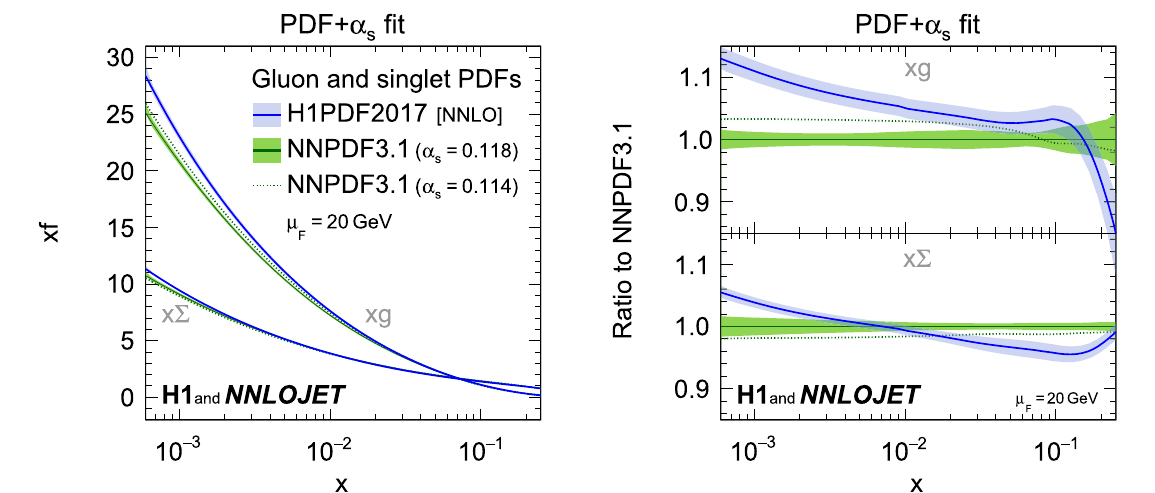
Fig. 16 Gluon and singlet distributions determined by the PDF+ α s -fit, denoted as H1PDF2017[NNLO], as a function of the convolution variable x . The distributions are displayed at μ F = 20GeV. The PDFs are compared to the NNPDF3.1 PDFs determined with values of α PDF s ( m Z ) of 0.114 and 0.118. Ratios to NNPDF3.1 are shown in the right panels